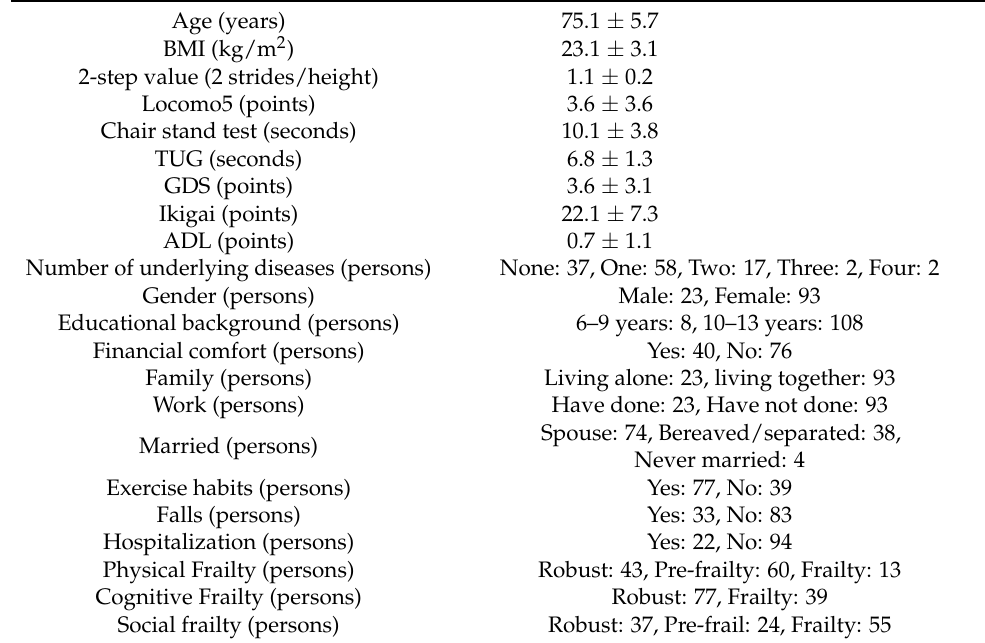
Table 1. Characteristics of the participants.